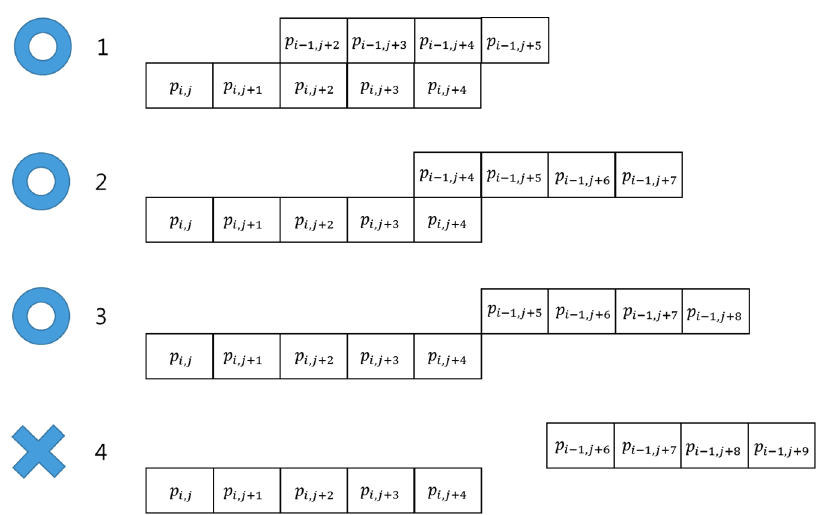
Figure 8. Examples of line